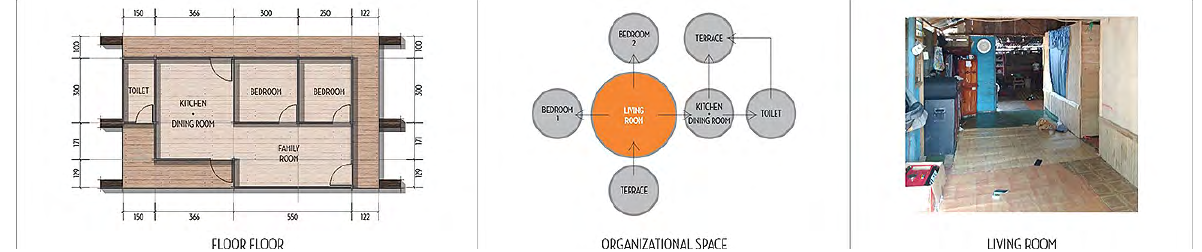
Figure 9. (a) Floor plan case 1; (b) Organizational space case 1; (c) Living room case